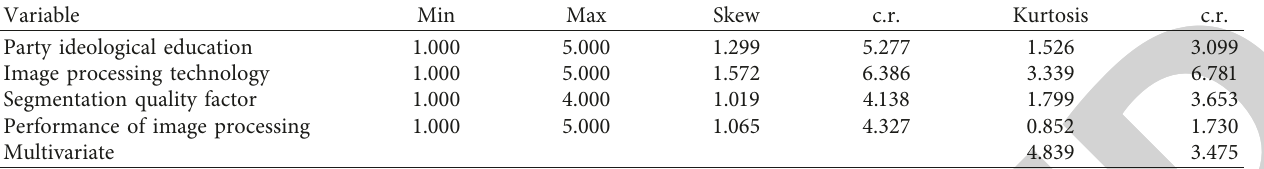
Table 2: Assessment of normality.